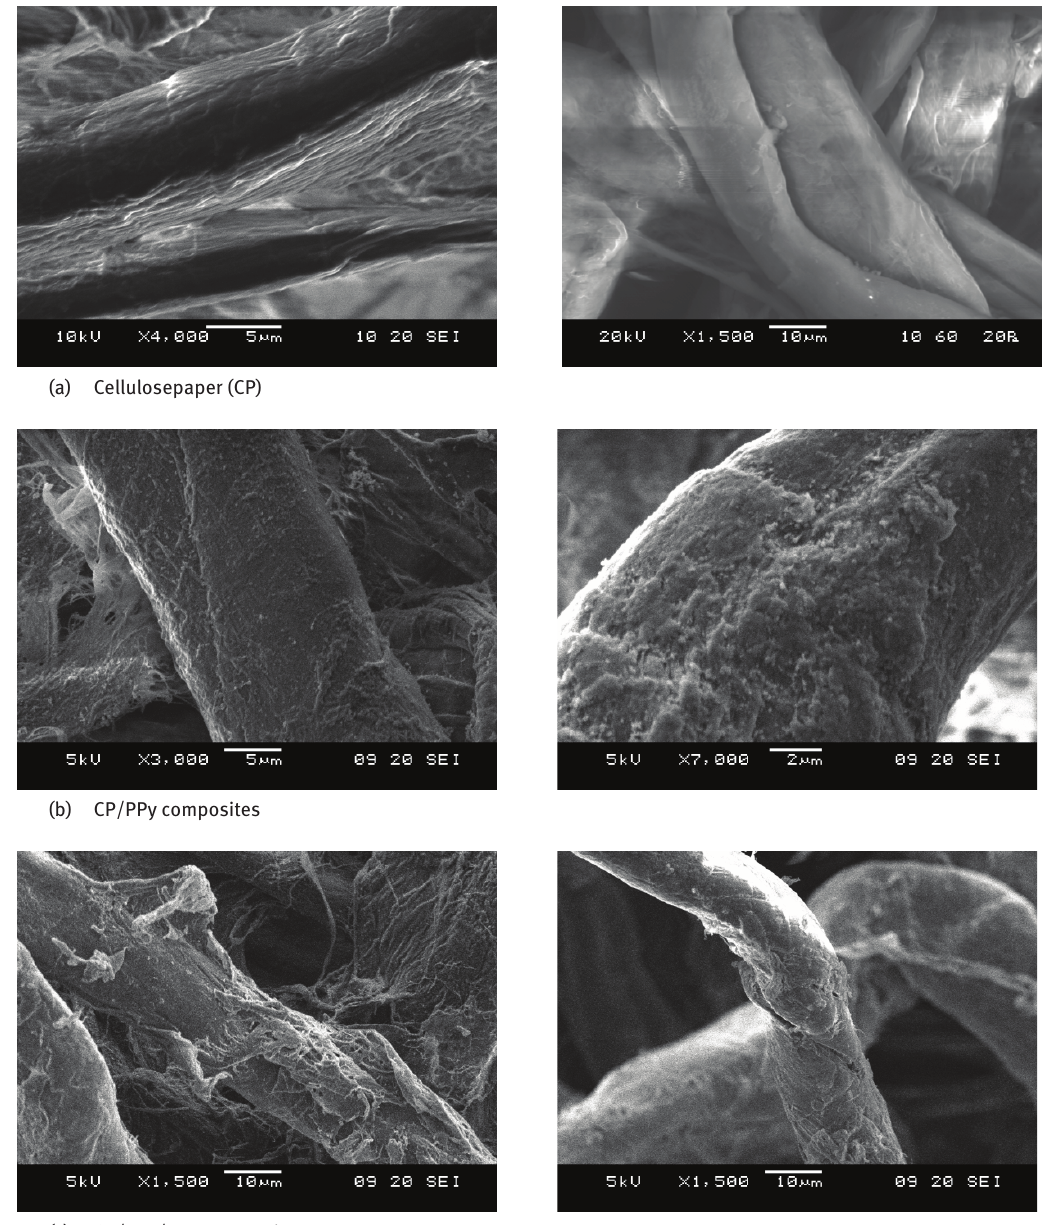
Figure 4: SEM images for: CP (a), CP/PPy (b) and CP/PPy/BPB